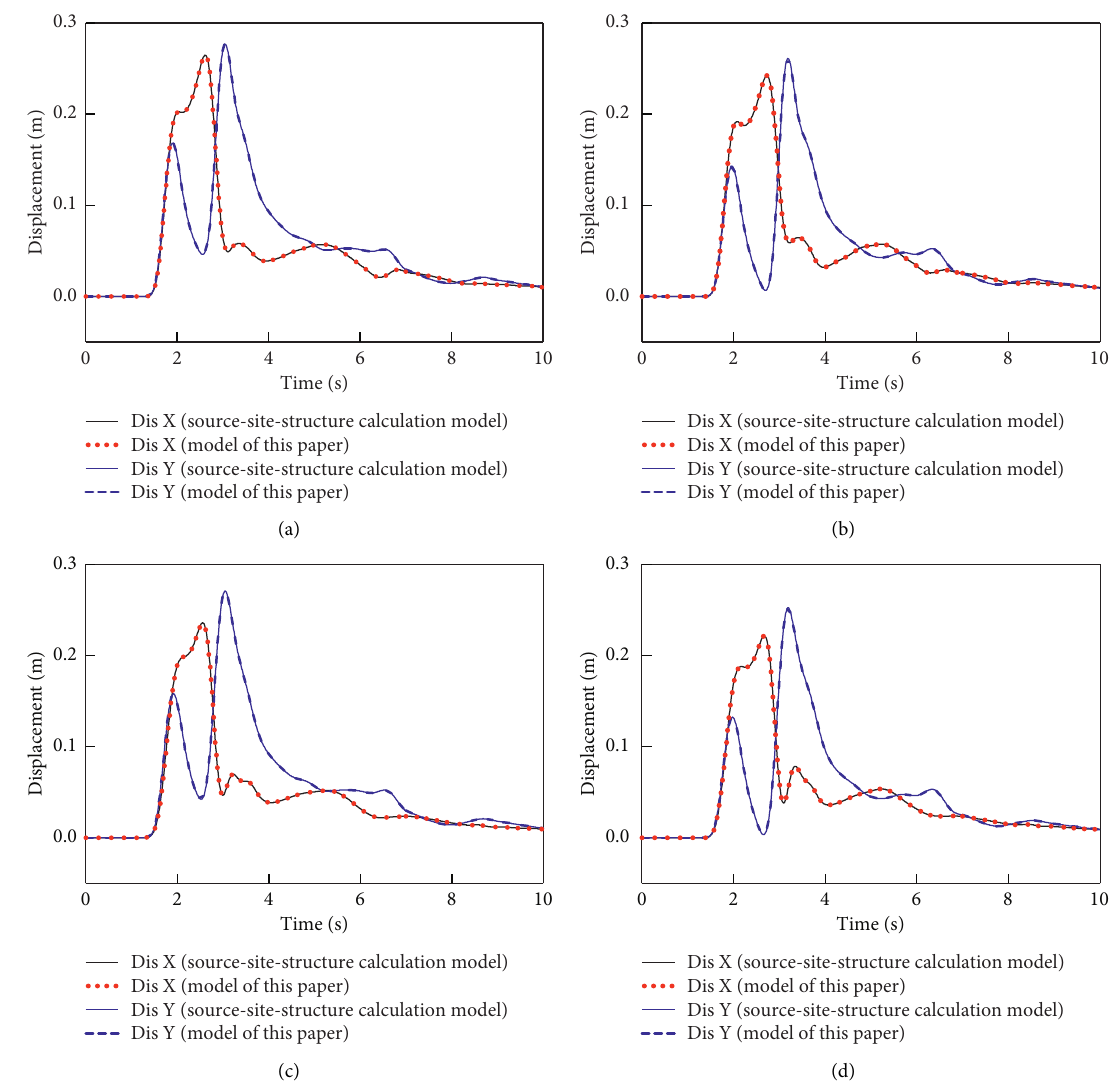
Figure 12: Displacement history of the nodes of the artificial boundary elements: (a) node 1, (b) node 2, (c) node 3, and (d) node